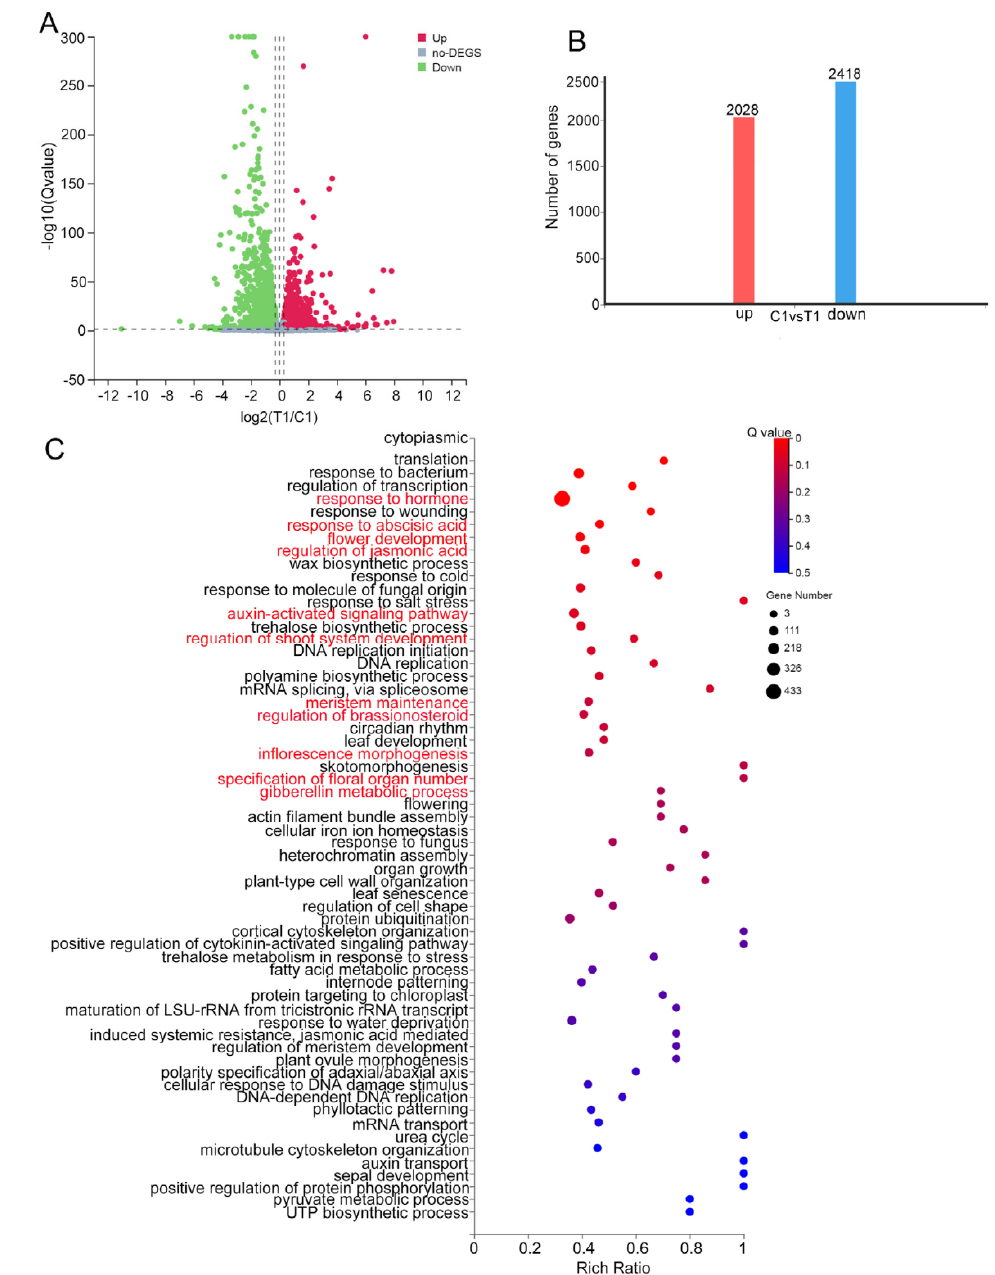
Figure 6. Differentially expressed genes statistics and GO analysis. ( A ) Volcano plots were used to visualize RNA sequencing (RNA—Seq) data. Each point corresponds to a reference sequence (Ref Seq) Gene. Red and green represent upregulated and downregulated genes in vpb1 lines compared with WT. T1: Mutant treatment group, C1: Wild type control group. ( B ) Statistics of the number of differentially expressed genes. Red represents upregulated DEGs, blue represents downregulated DEGs. ( C ) Gene ontology (GO) analysis functional categories of genes that differed in abundance between vpb1 and WT. Biological pathways related to hormone signaling and inflorescence architecture are indicated on the left and marked in red. Points of different color and size represent gene numbers.